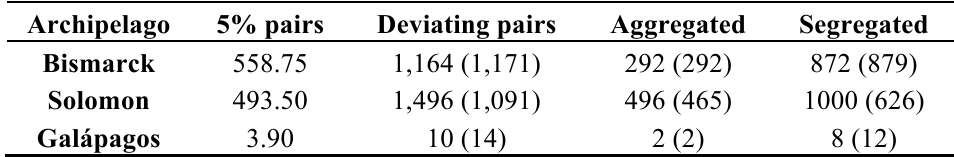
Table 2. The results of co-occurrence analysis using the ‘natural’ metric for the three data sets for birds previously analyzed by Sanderson [12] and Sanderson et al. [15]. 5% pairs indicate the 5% of all possible species pairs in the matrix that are expected to deviate by chance alone. Deviating pairs indicate the actual number of deviating species pairs found by the ‘natural’ metric. In parentheses, the respective numbers of species pairs given by Sanderson [12] and Sanderson et al. [15].